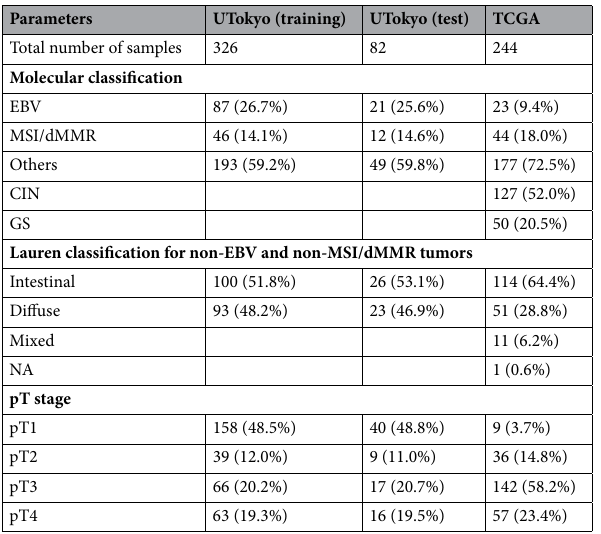
Table 1. Pathological information of cohorts included in this study. UTokyo, University of Tokyo; TCGA, The cancer genome atlas; EBV, Epstein-Barr virus; MSI, Microsatellite instability; dMMR, mismatch repair deficiency; CIN, chromosomal instable; GS, genomically stable; NA, not available.